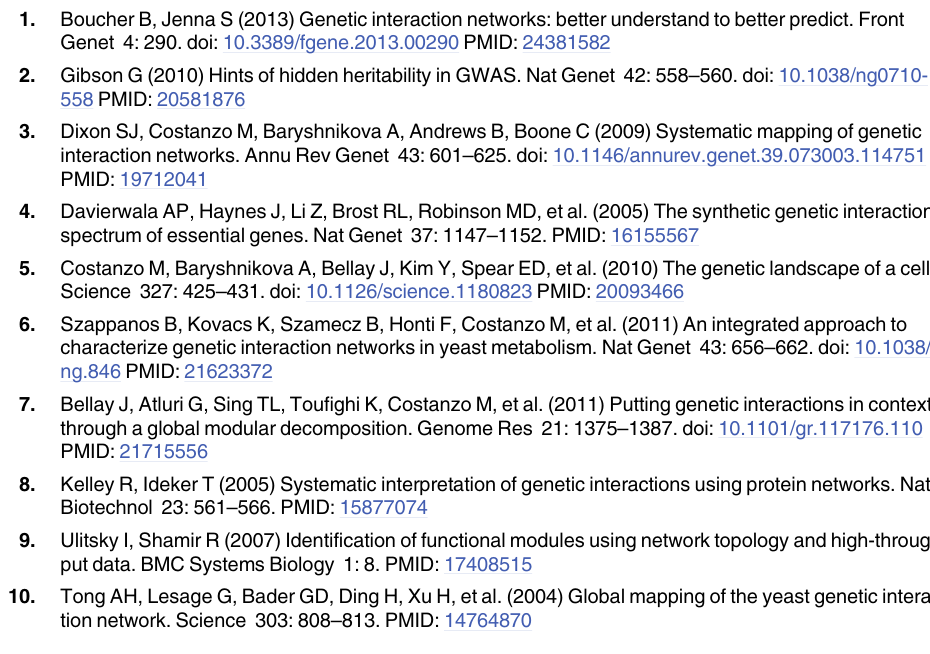
S1 Table. GIs-all with selected GI classes. (See Methods.) S2 Table. Gene Ontology terms enriched amongst genes in GI classes. S3 Table. C . elegans signaling pathways curated from the literature. (See Methods.) S4 Table. Genes involved in the same pathway and either involved in the same PDS or in different PDS. S5 Table. Log odds ratio and hypergeometric test P -value relative to S17 Fig. S6 Table. GI groups. Thresholds used to identify GI groups associated to a positive or negative value for attributes as well as the size of each